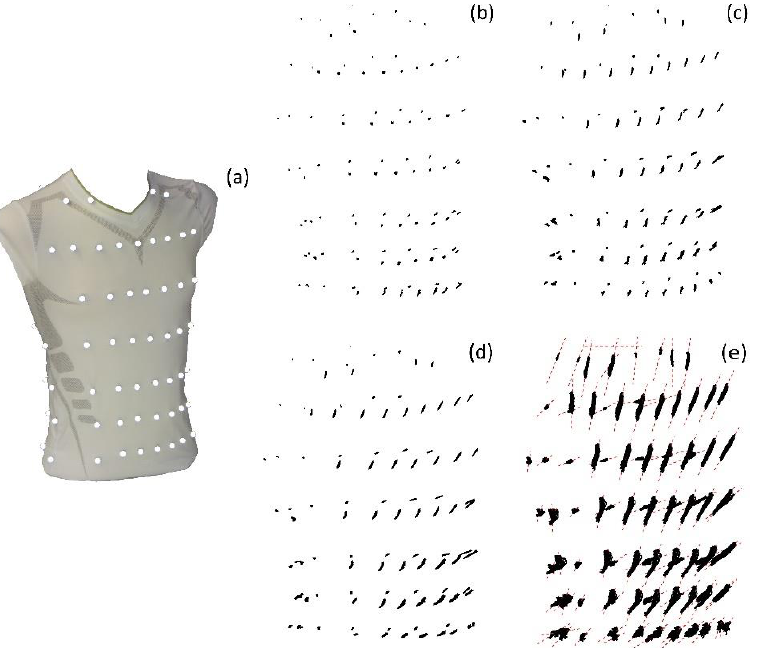
Figure 8. Spatial movement of the MoCap markers on the compression shirt ( a ) during shallow breathing ( b ), normal spontaneous breathing ( c ), medium breaths ( d ) and maximal breaths ( e ), illustrated based on the data of subject 5. The MoCap markers move predominantly on a specific line, which are illustrated in ( e ) as red dashed lines.